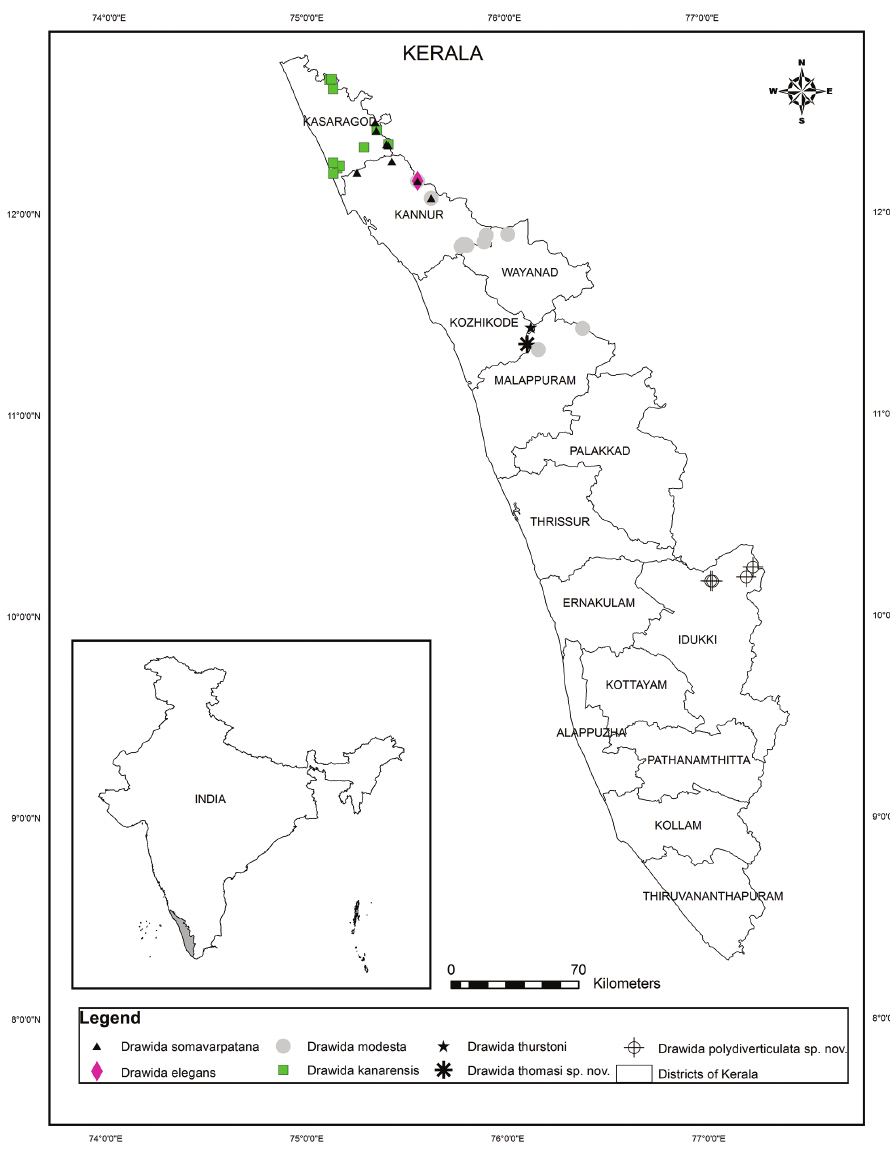
ecal atria bilobed, one lobe in segment 7 and the other in segment 8; atrial lobes tubular, very long, 9–10 mm in length, coiled into compact masses. Nephridiopores aligned with d. Description. Colour bluish; body circular, slightly flattened dorsoventrally. Dimen- sion: Holotype 66 mm by 4.5 mm at segment 9, 105 segments; paratypes 55–57.5